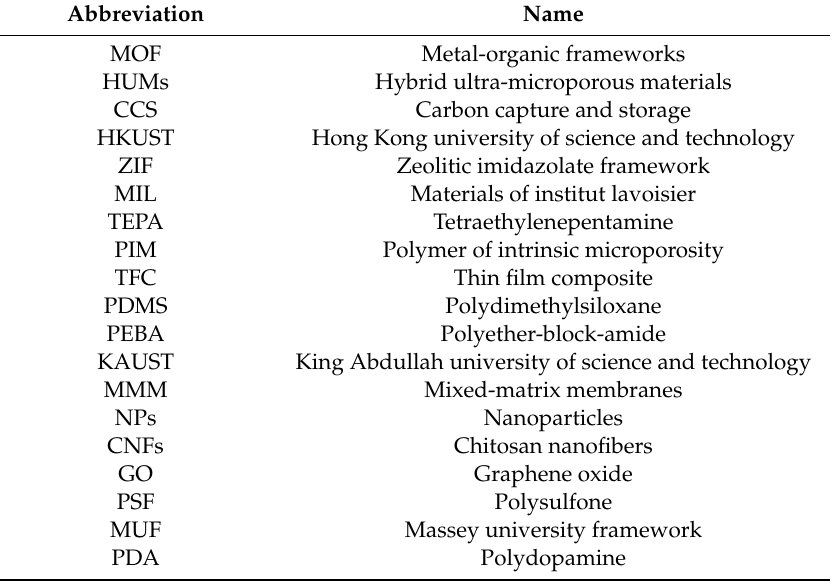
Table 4. List of the abbreviations and acronyms used in this review